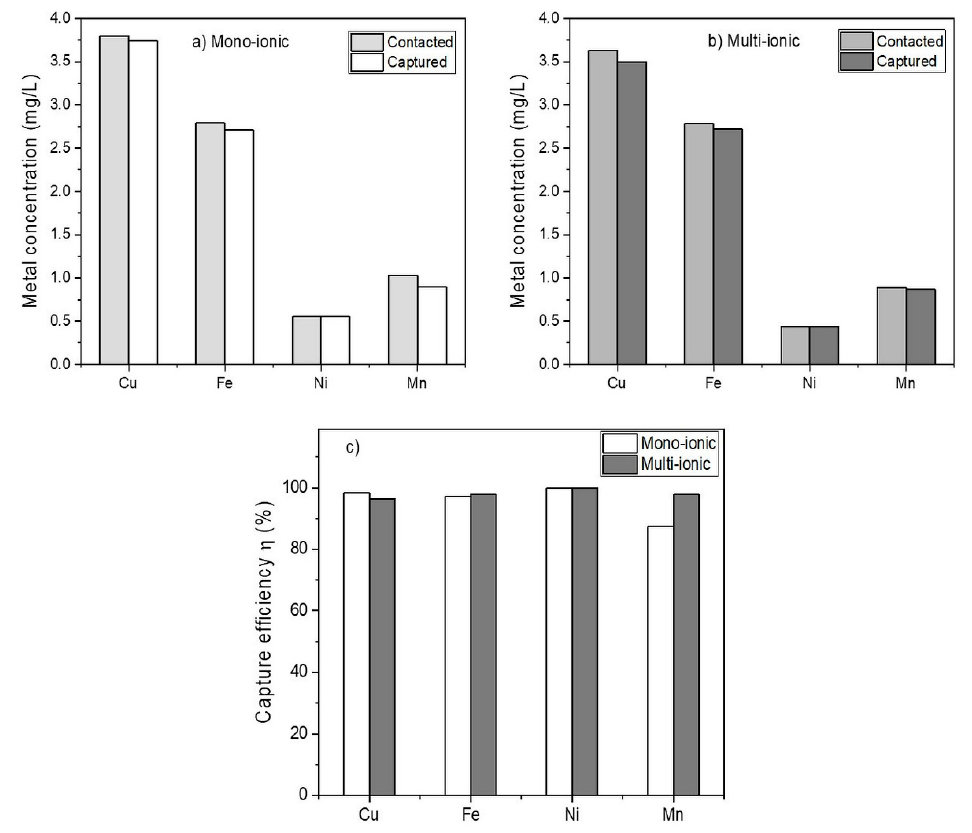
Figure 7. Results of capture tests performed on 54.7 cm 3 monolith using mono-ionic ( a ) and multi-ionic ( b ) solutions; a comparison of capture efficiencies for both feeds is reported in ( c